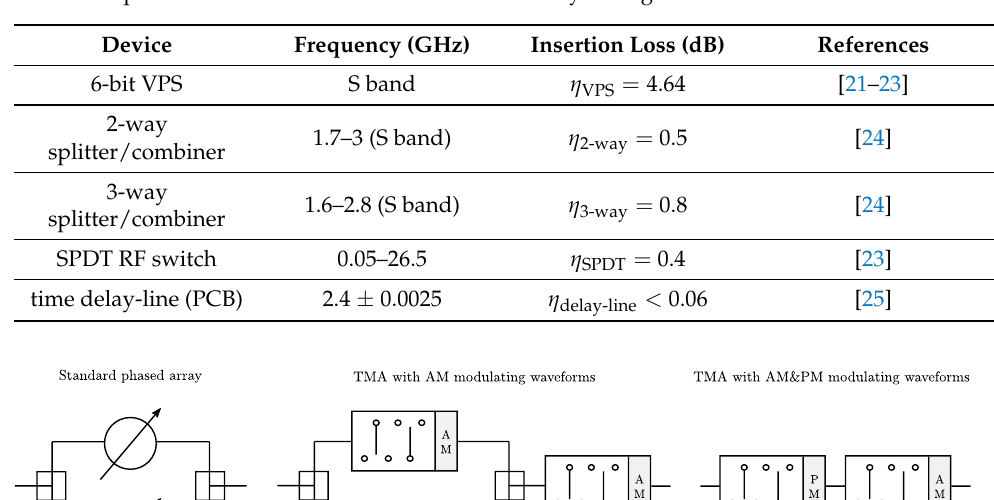
Table 3. Examples of devices working in the f c = 2.4GHz WSN frequency band that can be used in a suitable implementation of the dual-beam steerable arrays in Figure 8.